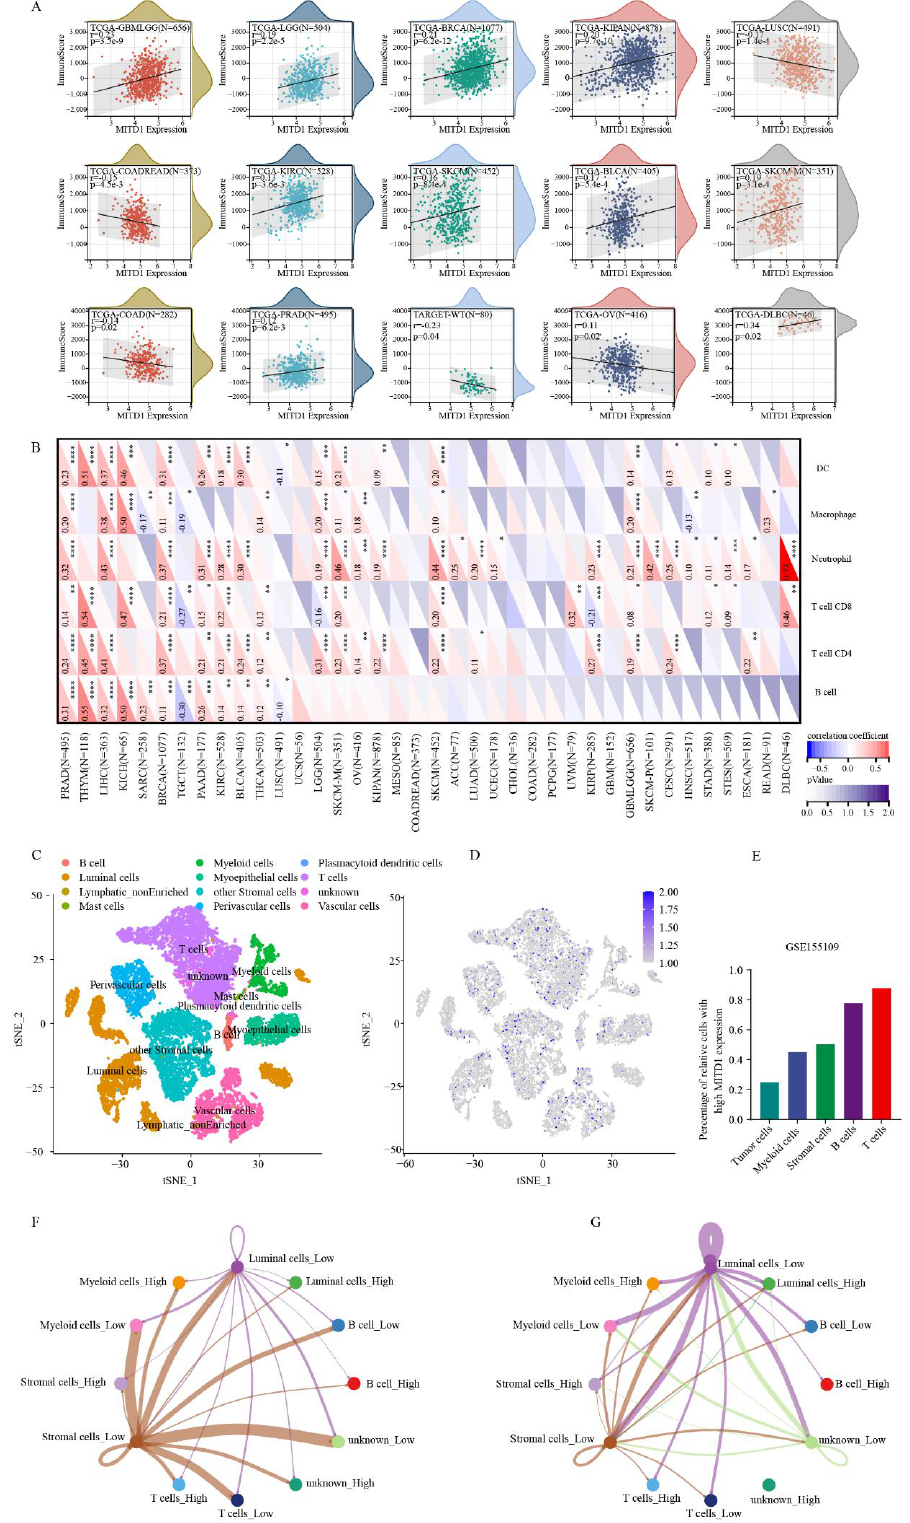
Figure 3. The correlation of MITD1 expression with immune infiltration levels. ( A ) The correlation between MITD1 and immunescore. ( B ) The correlation between MITD1 and immune cells. ( C ) Cells from the GSE155109 dataset were mapped on the tSNE plot. ( D ) tSNE plot illustrating MITD1 expression profile at the cell level. ( E ) Percentage of relative cells with high MITD1 expression. ( F , G ) Intercellular communication networks among different cell types. * p < 0.05; ** p < 0.01; *** p < 0.001; **** p <